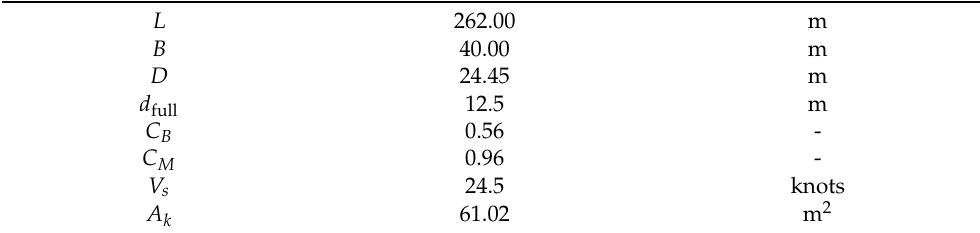
Table 13. Principal dimensions of C11 container